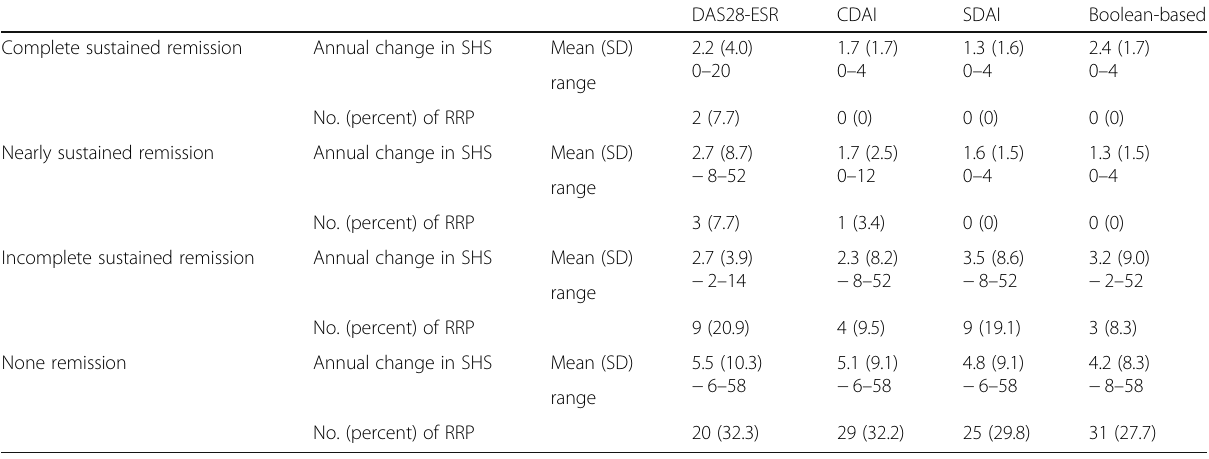
Table 4 Radiographic progression of patients who sustained clinical remission according to each criterion during follow-up period